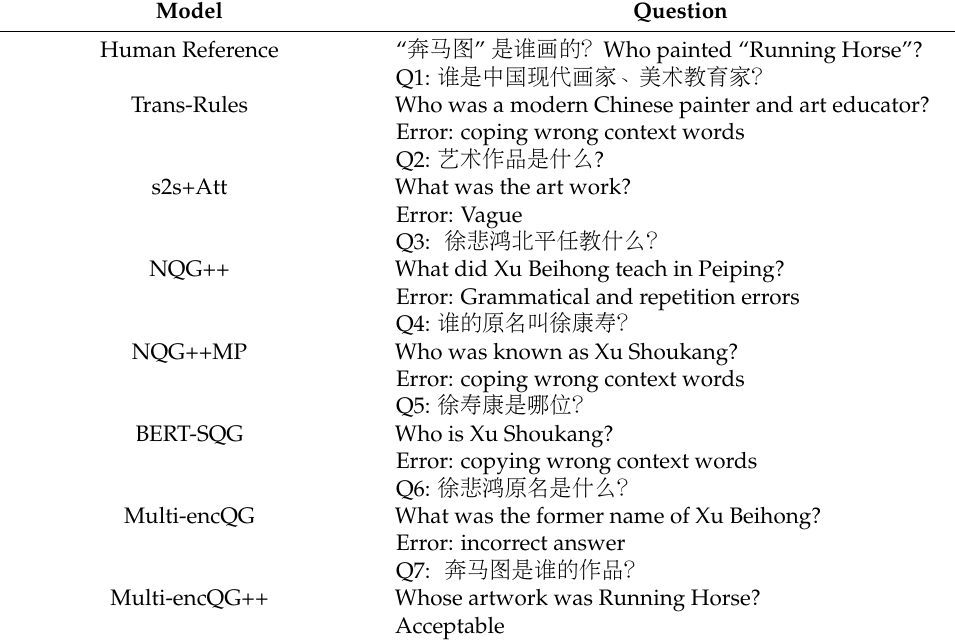
Table 5. Questions generated from the example in Table 1 based on different